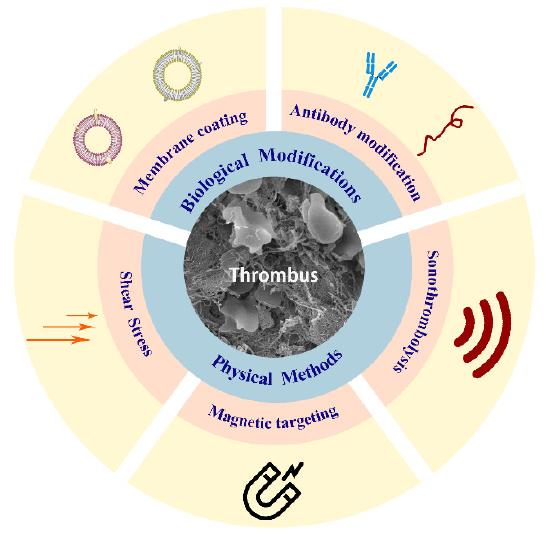
Figure 1. Schematic illustration of the main methods in modification of thrombolytic drug delivery nanocarriers.